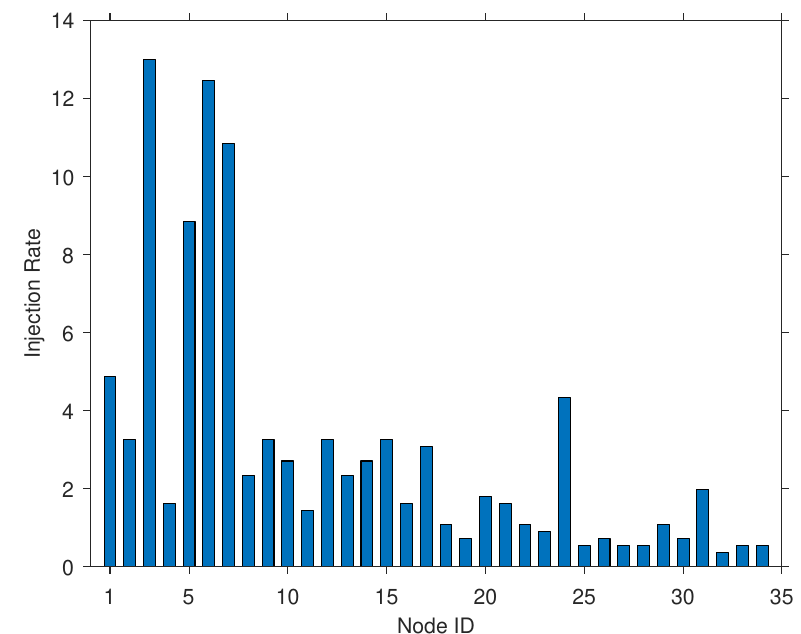
Figure 4. Packets injection rates of captured network traffic in a hotel.